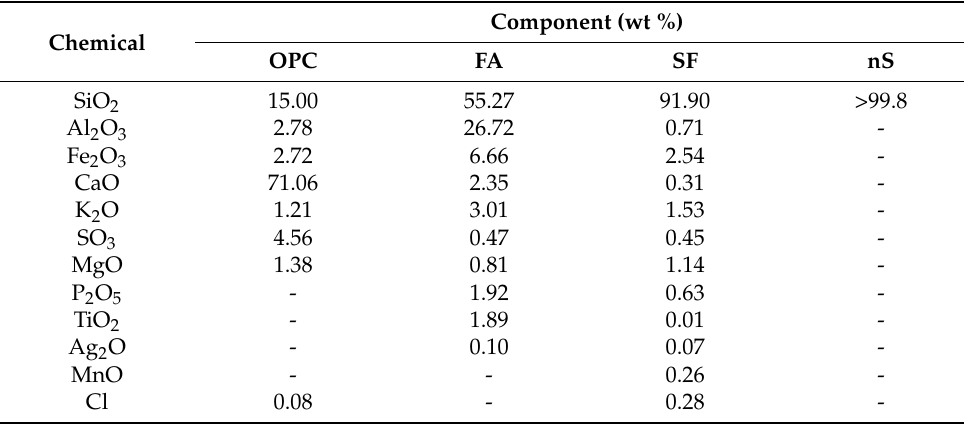
Table 4. Chemical constituents of SCMs